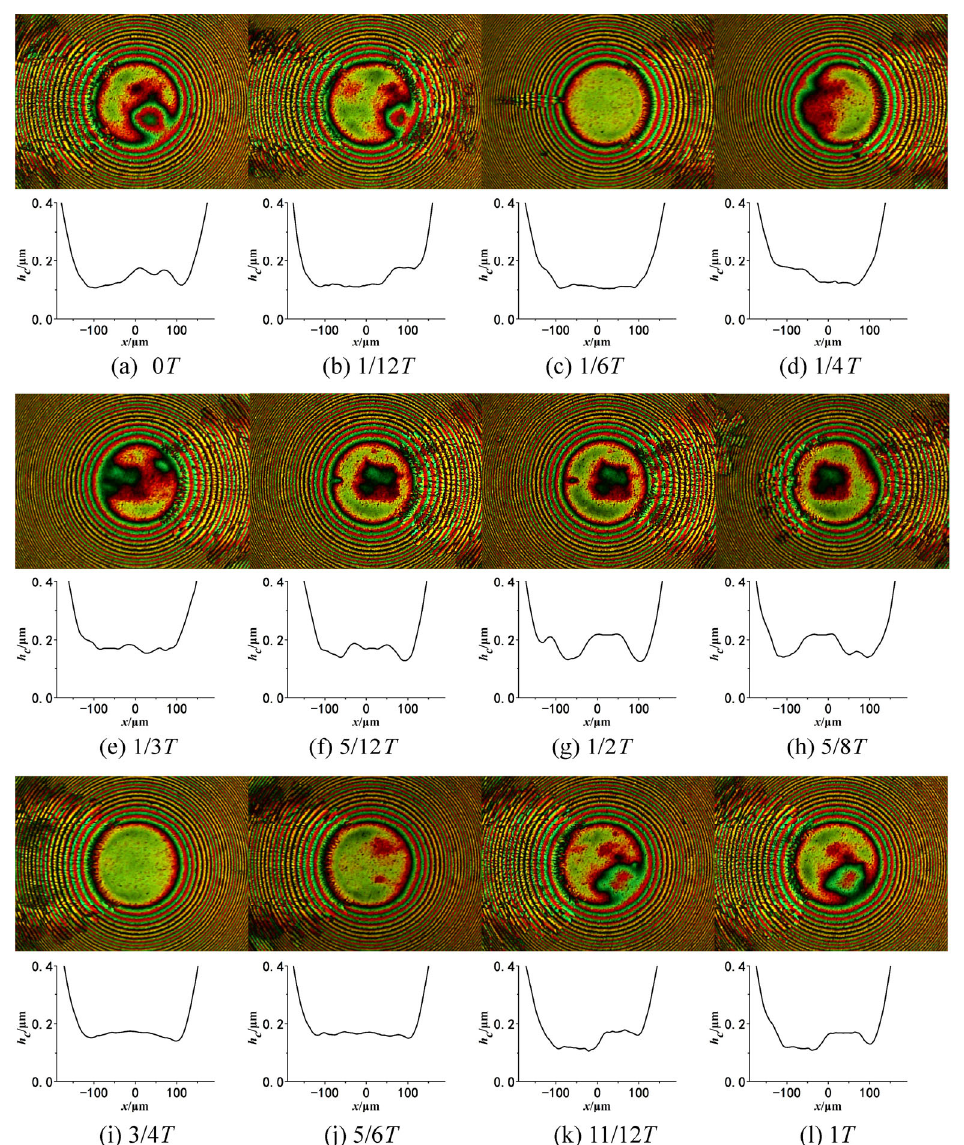
Fig. 6 Interferograms and midsection film thickness during 5th cycle under pure rolling reciprocating motion ( v max = 0.01 m/s, w = 15 N, T = 0.5 s, L = 1.25